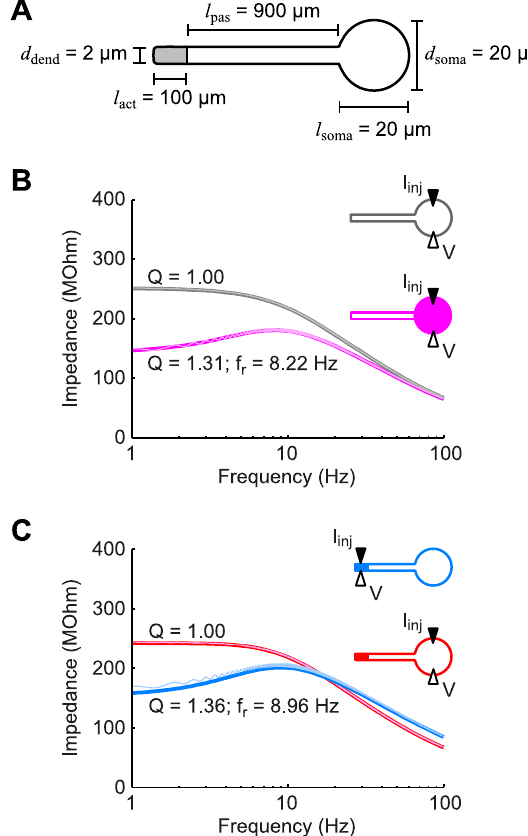
Figure 1. Dendritic resonance may not be detectable in somatic measurements. (A) Schematic of the standard model used through- out the study showing the spatial dimensions of the soma and dendrite. The soma and proximal part of the dendrite had passive membrane properties while the distal, dendritic end (gray) had voltage-dependent h-conductances. (B) The somatic input impedance of a passive neuron (gray) demonstrated low-pass behavior. When h-conductances were added to the soma (magenta curve), this resulted in a band-pass filtered response. (C) If the h-conductances were located in the distal dendritic end as in panel (A), a resonance was observed in the dendritic input impedance (blue curve), but was not detectable somatically (red curve). Thin curves in panels (B) and (C) correspond to numerical results from the full nonlinear model (see